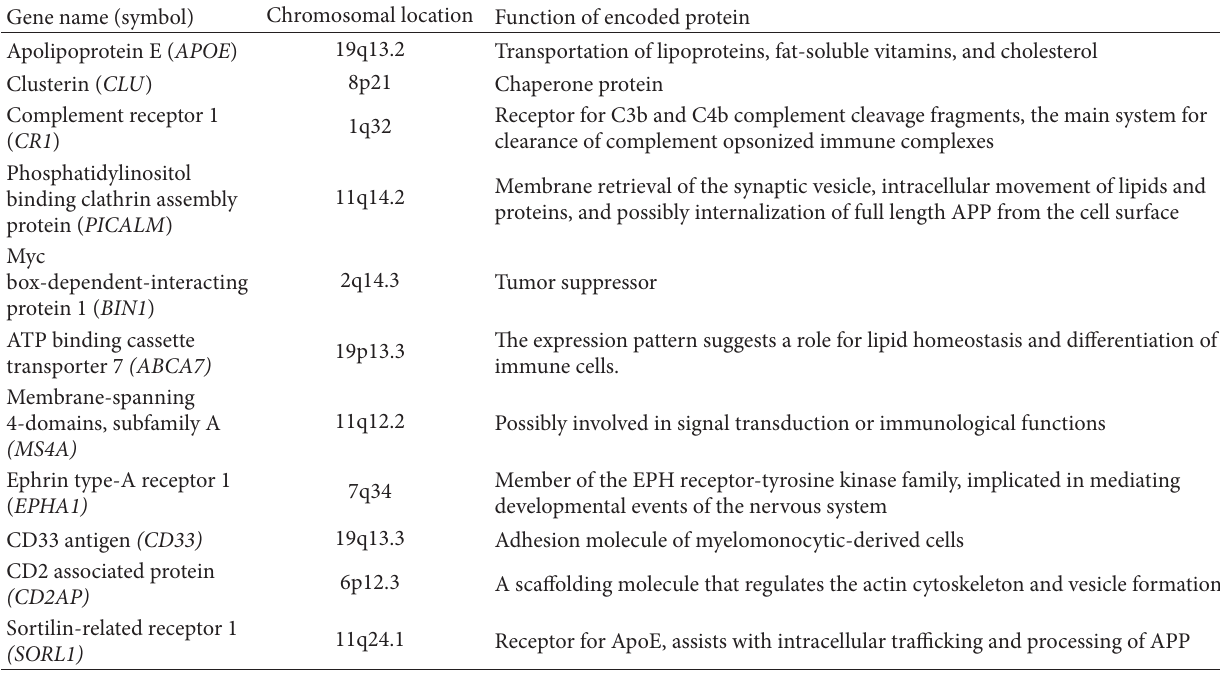
T 2: Genes reliably implicated in risk for late-onset Alzheimer’s disease, including chromosomal location and